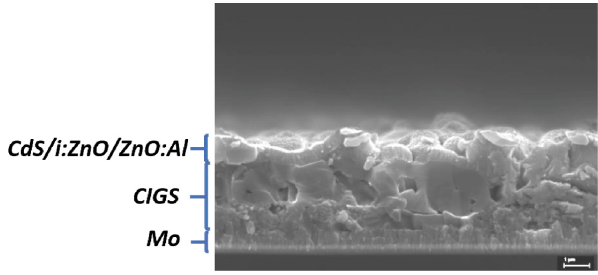
Fig. 4. SEM cross section of the complete CIGS solar